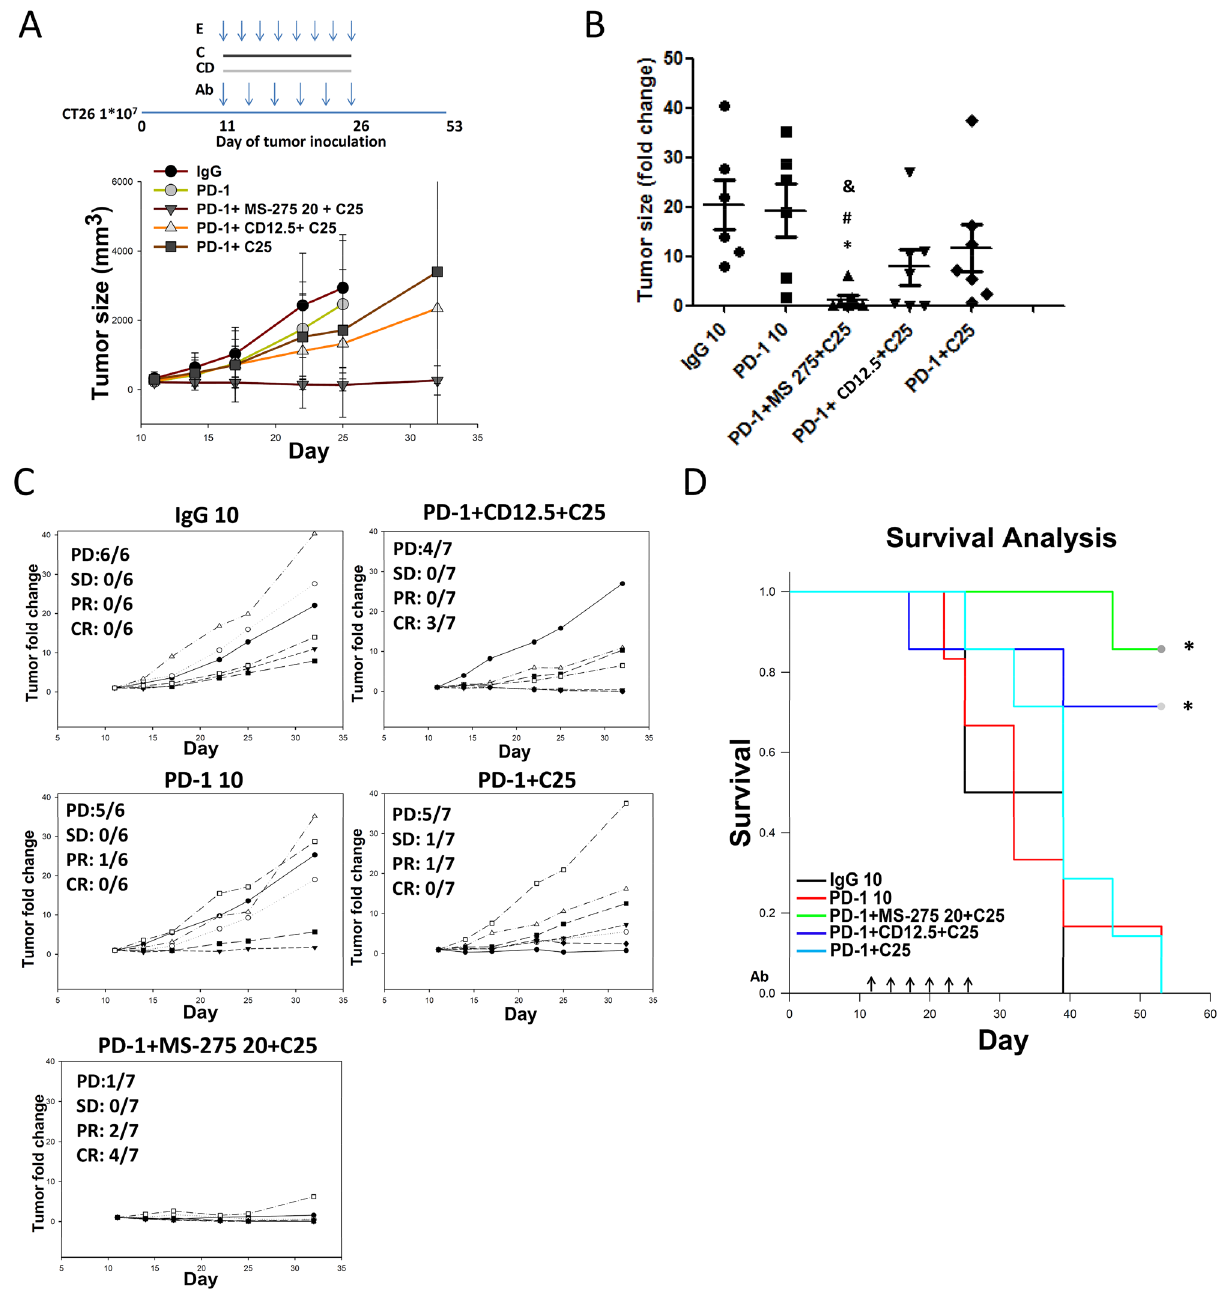
Figure 1. Chidamide + celecoxib enhances anti-PD-1-induced immunotherapy in an allograft CT26 mouse model. ( A ) CT26 tumor-bearing mice were orally administered a chidamide-k30 solution (CD, 25 mg/kg) once daily from days 11 to 26 (Day 11 mean TV, 200–250 mm 3 ), entinostat (E, 20 mg/kg) once every 2 days from days 11 to 26, and celecoxib (C, 25 mg/kg) once daily from days 11 to 26. Arrows indicate the time points at which mice were treated with the anti-PD-1 antibody. The mice were treated with anti-PD-1 antibody (10 mg/kg, i.p.) once every 3 days on days 11, 14, 17, 20, 23, and 26. Entinostat (MS-275), as a positive control, was administered with anti-PD-1 following the indicated schedules. ( B ) Endpoint tumor size is presented as tumor volume (TV) and fold change. Results are shown as mean ± standard error of the mean (SEM). *p < 0.05 vs. anti-IgG; # p < 0.05 vs. anti-PD-1; & p < 0.05 vs. CD25. ( C ) Individual tumor growth graphs for CT26 tumor-bearing mice (n = 6–7). Number of tumor-free mice per total number of mice is shown at the top left corner of each panel. ( D ) Survival study of all the treatment